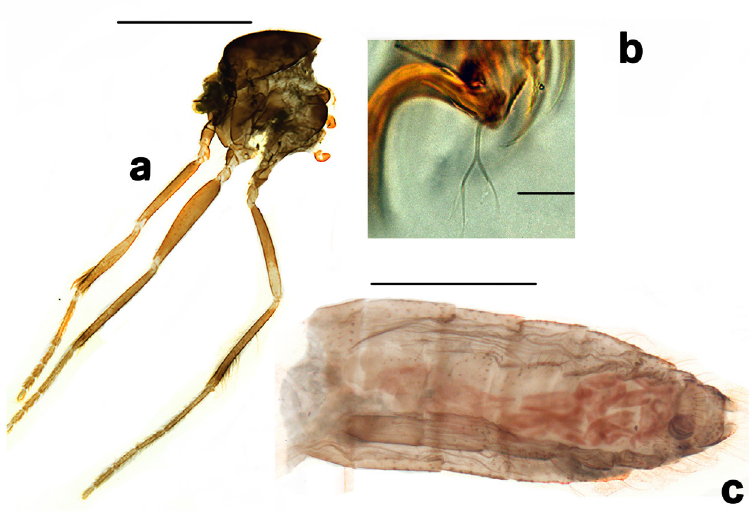
Fig. 8. Microphotography of Corethrella menini Feijó, Picelli, Ríos-Velásquez & Pessoa sp. nov. ♀ , holotype (ILMD 0001 - 57). a . Thorax and legs. b . Tarsal claw with empodia. c . Abdomen. Scale bars: a–c = 500 μm; b = 10